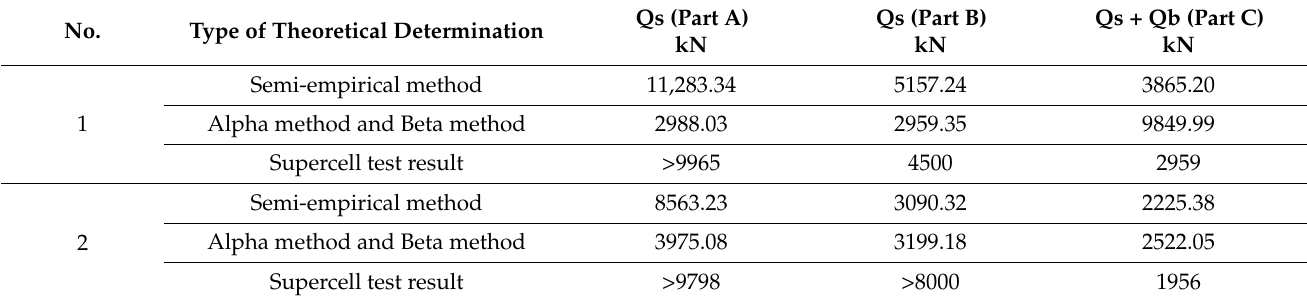
Table 7. Estimated and interpreted results with test